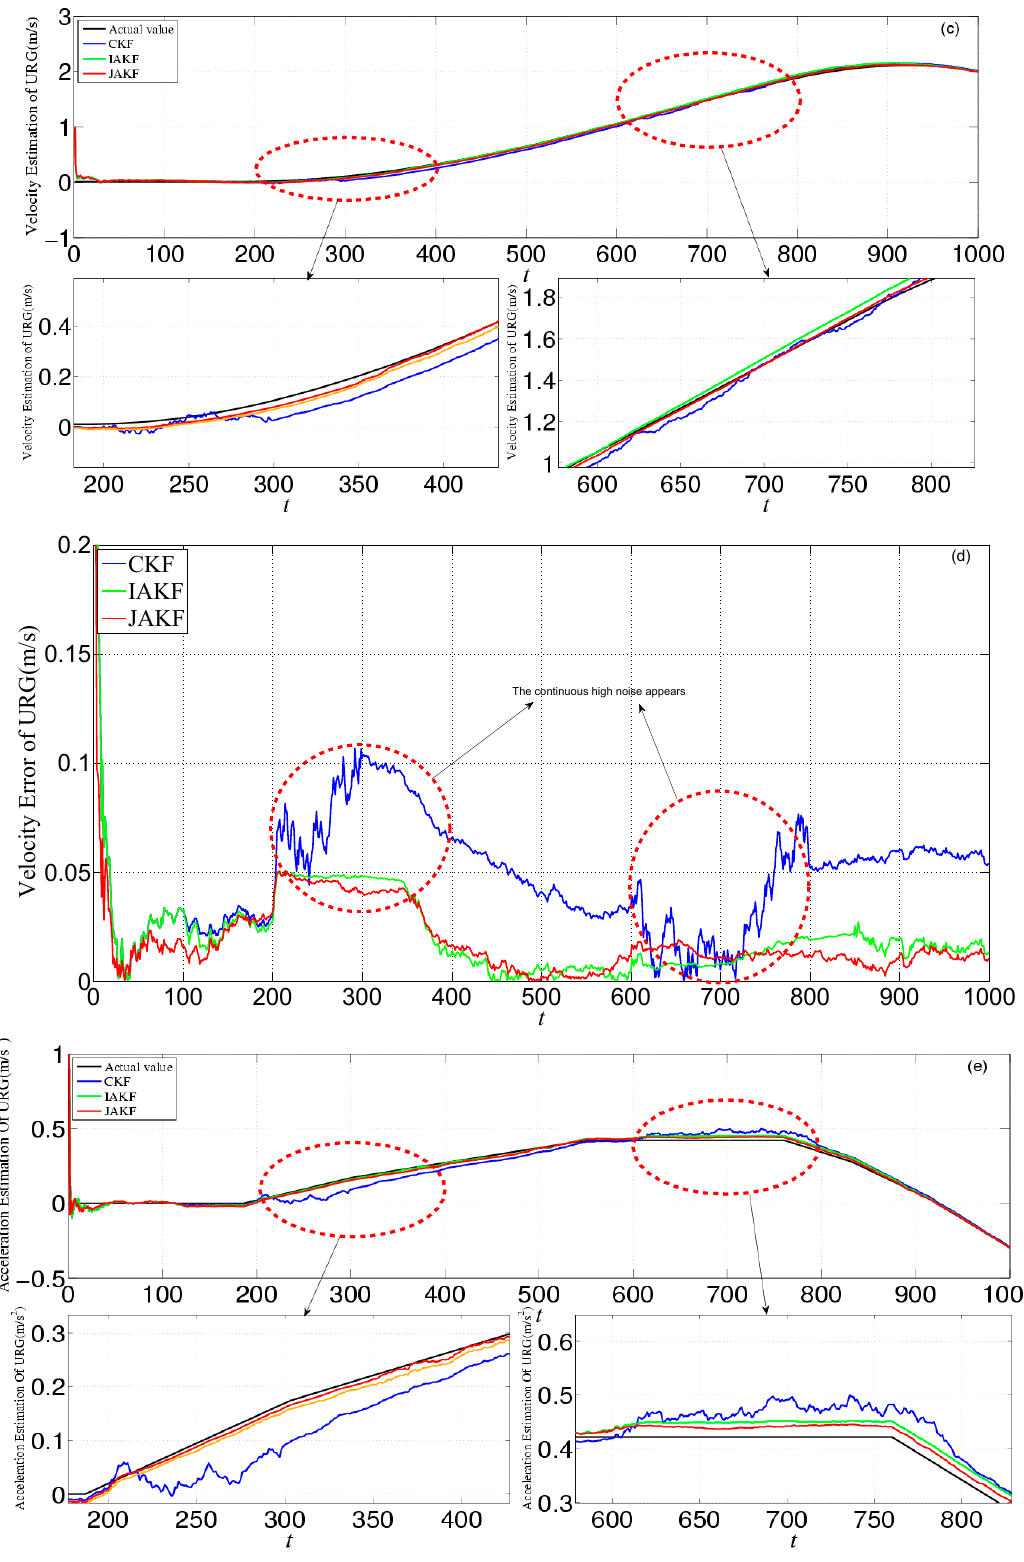
Figure 18 . Cont . Figure 18.